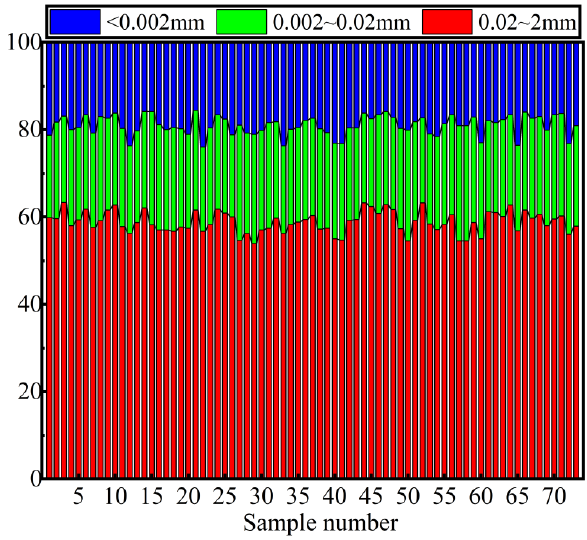
Figure 3. Particle size distribution of sewer sediment samples.